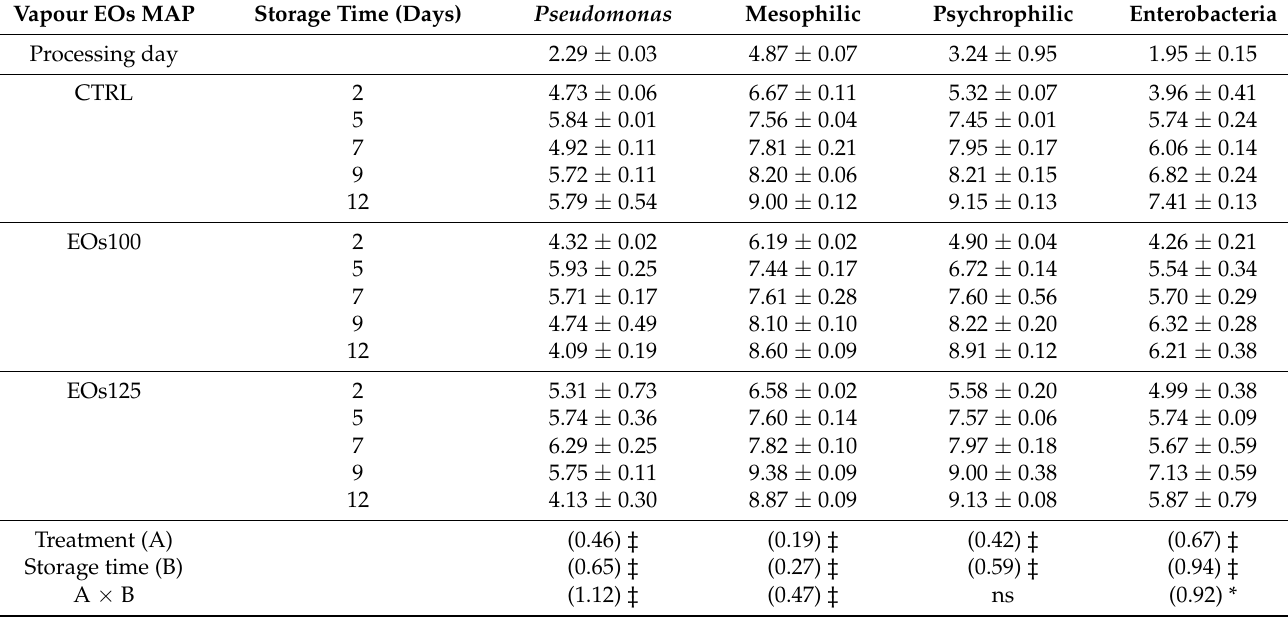
Table 2. Microbial loads (log CFU g − 1 ) of sliced mushrooms during cold storage (4 ◦ C) under modified atmosphere packaging (MAP) supplemented with vapour essential oils (100 and 125 µ L L − 1 EOs) (mean ± standard deviation). Vapour EOs